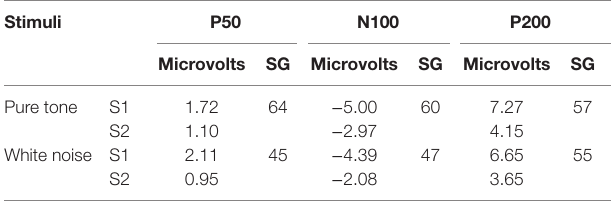
TaBle 2 | Mean amplitude (microvolts) and sensory gating (sg) scores (s2–s1 ratio) of auditory-evoked potentials ( n = 23). stimuli